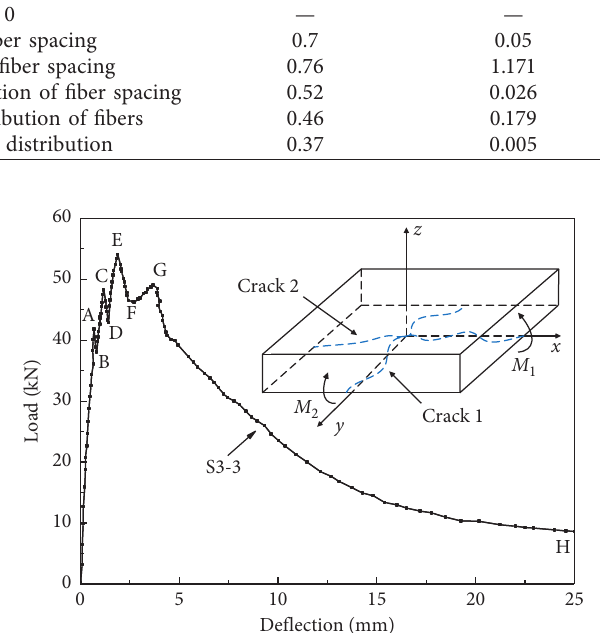
Figure 4: The load-deflection curve of a square slab with 4.5kg/m 3 content.